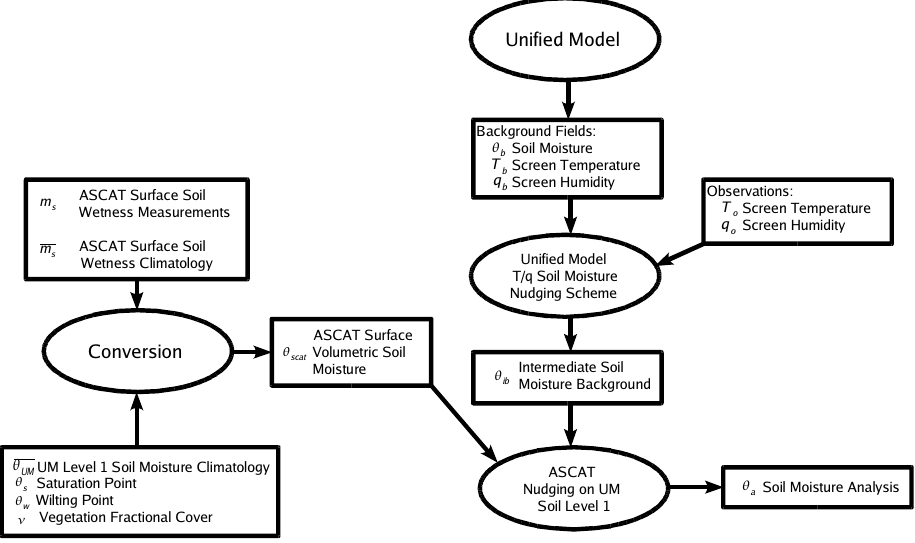
Fig. 1. Schematic view of the soil moisture analysis scheme used by the Test experiments in this study. The Test experiments use ASCAT surface soil wetness measurements and screen level temperature and humidity observations to analyse soil moisture.